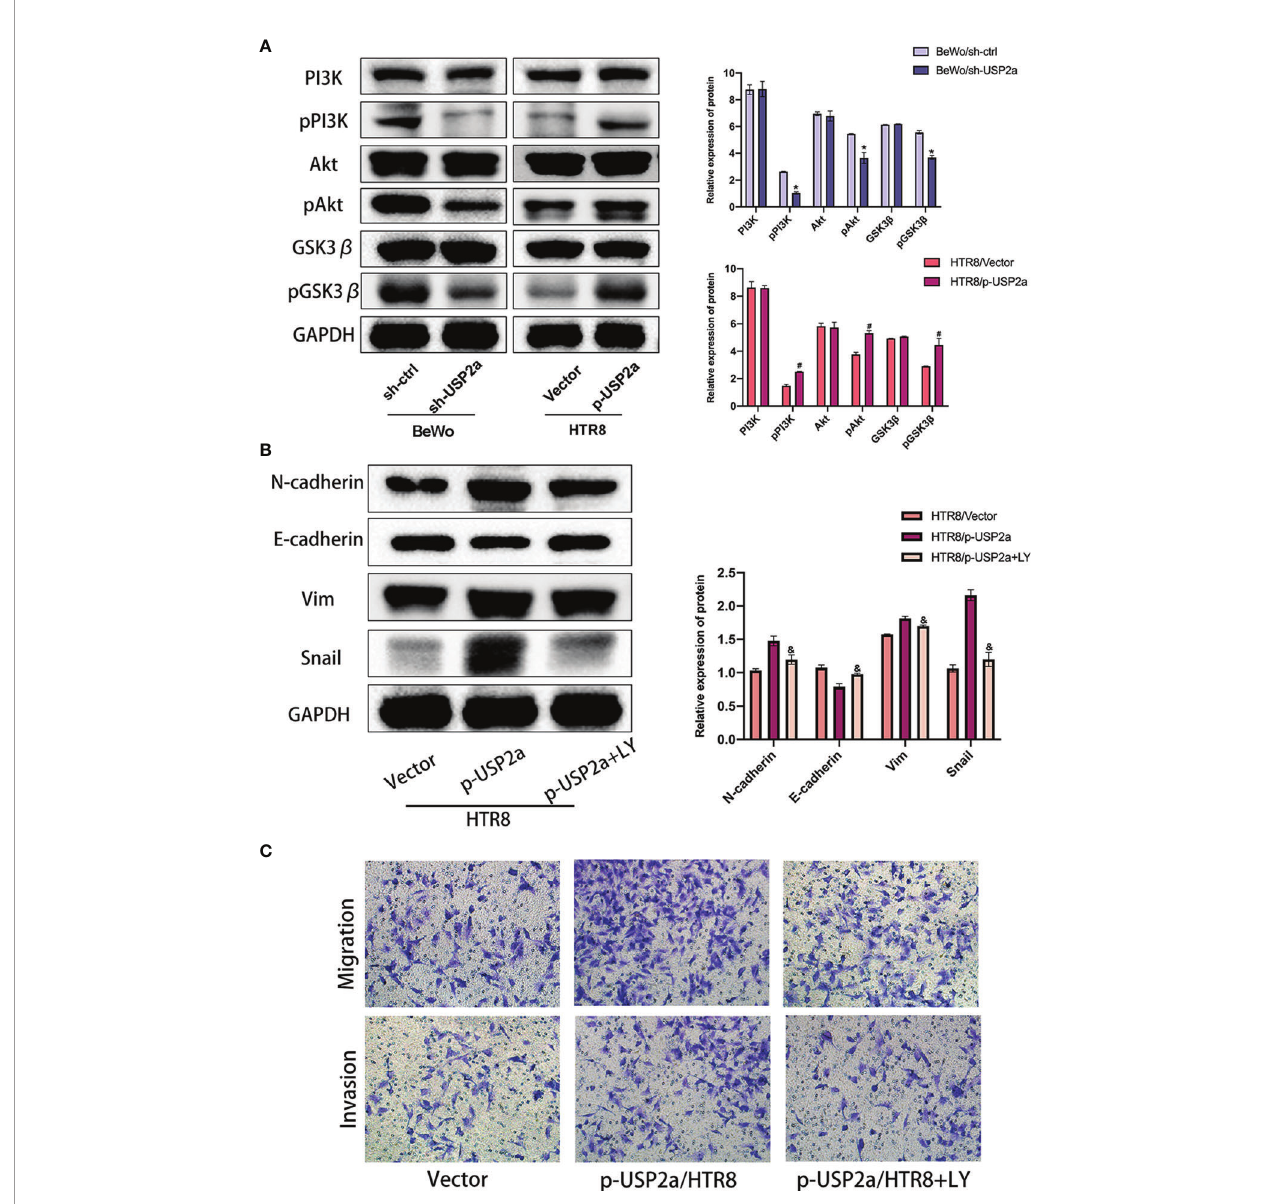
FIGURE 5 | USP2a promotes EMT, migration and invasion of trophoblasts via activating PI3K/Akt/GSK3 b pathway. (A) Western blot analyzes relative protein level of sh-Ctrl/BeWo, sh-USP2a/BeWo, Vector/HTR8, p-USP2a/HTR8. (B) Western blot analysis of sh-Ctrl/BeWo, sh-USP2a/BeWo, Vector/HTR-8, p-USP2a/HTR8 in the presence or absence of LY29004 (20 m M). (C) Migration and invasion capacity in sh-Ctrl/BeWo, sh-USP2a/BeWo, Vector/HTR8, p-USP2a/HTR8 in the presence or absence of LY294002 (20 m M) was determined by transwell system. Representative photographs of migratory and invasive cells (magni fi cation, ×200) are shown. * P < 0.05, vs. sh-Ctrl # P < 0.05 vs vector. & P < 0.05 vs